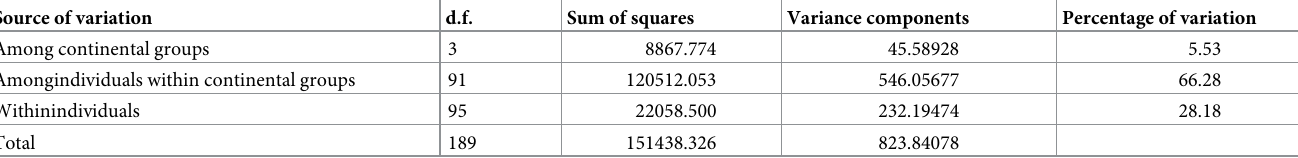
11.1% of the variation, respectively. The sesame panel was also divided into three clusters cor-